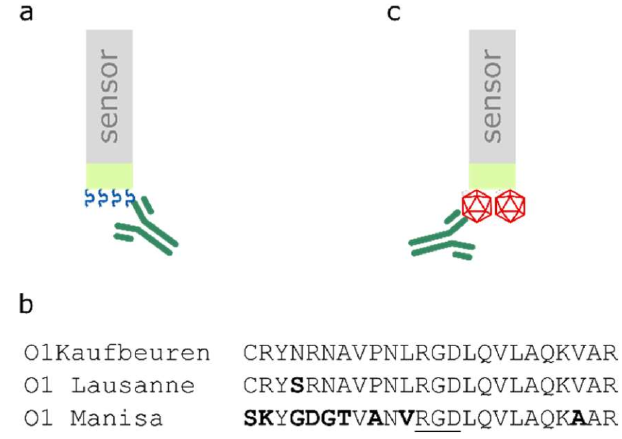
Figure 1. ( a ) Biotinylated peptides (blue) are loaded onto the streptavidin-coated Octet biosensor tip (lime) prior to dipping into antibody samples (green). ( b ) Amino acid sequences of GH-loop peptides relevant to this study. ( c ) Cartoon depicting the strategy of loading biotinylated O1 Manisa recombinant FMDV capsids (red) onto Octet biosensors.